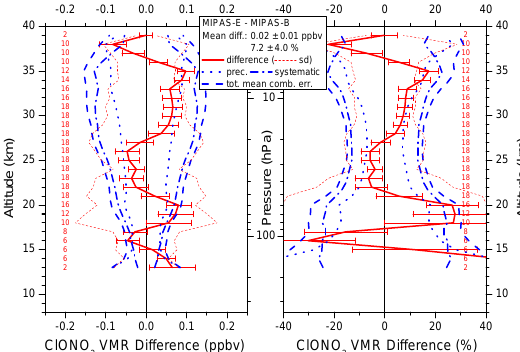
Figure 1: Mean absolute and relative ClONO 2 VMR differences of all collocations between MIPAS-E and MIPAS-B (red solid lines) including standard deviation (red dotted lines) and the standard error of the mean, plotted as error bars around the mean deviation together with precision (blue dotted lines), systematic (blue dash- dotted lines) and total (blue dashed lines) mean combined errors. Red values indicate the number of collocations used for the statistical analysis. Differences of ClONO 2 mixing ratios are well within the combined error